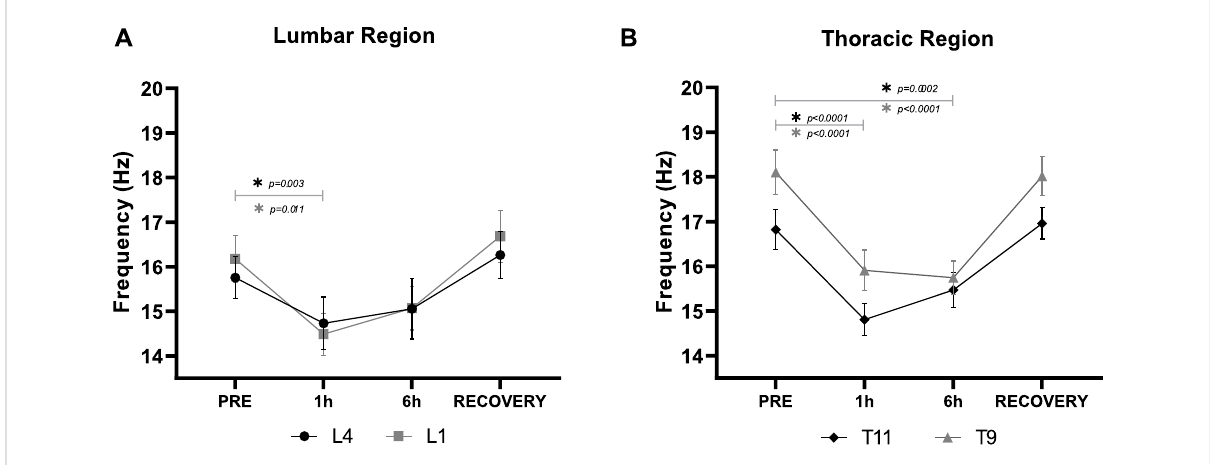
FIGURE 4 Mean(±SEM)bilateralm. erectorspinae myofascialtone(Hz)inthe (A) :LowerLumbar(L4)andUpperLumbar(L1),and (B) :LowerThoracic(T11), and Middle Thoracic (T9) regions before (PRE), during Dry Immersion (DI) after 1 (1 h) and 6 (6 h) hours, and 30 min after being raised out of DI (RECOVERY). *Statistically signi fi cant difference ( p < 0.05) between time points (post-hoc Bonferroni corrected t -tests).